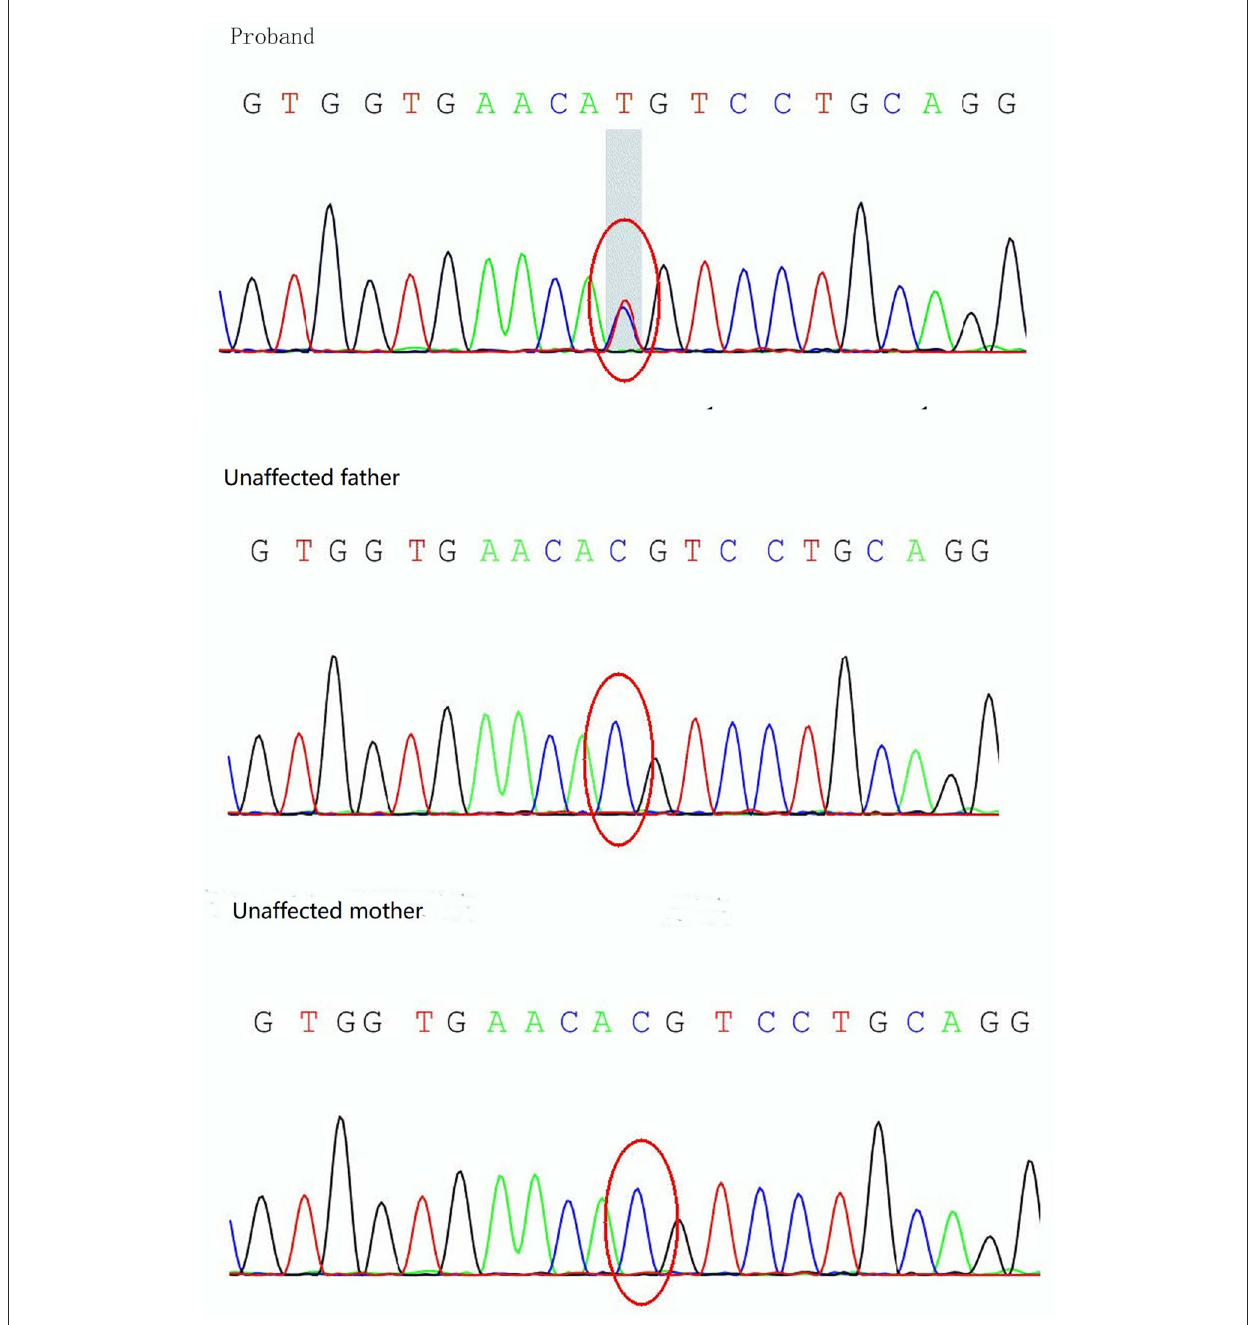
FIGURE3 Sanger sequencing analysis of the KCNJ11 gene showing detection of a mutation, c.175G > A (p.V59M), in the proband.